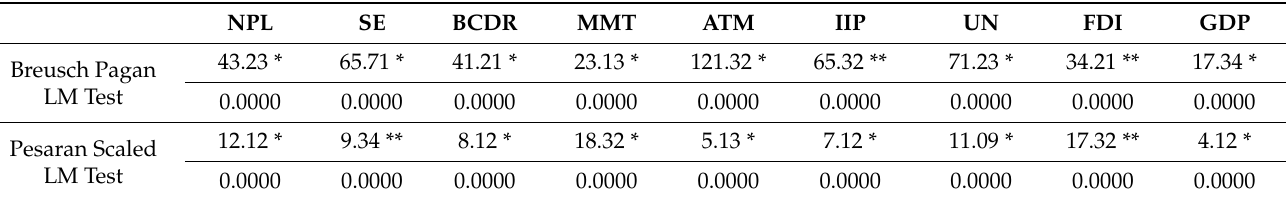
Table 2. Cross sectional Dependency